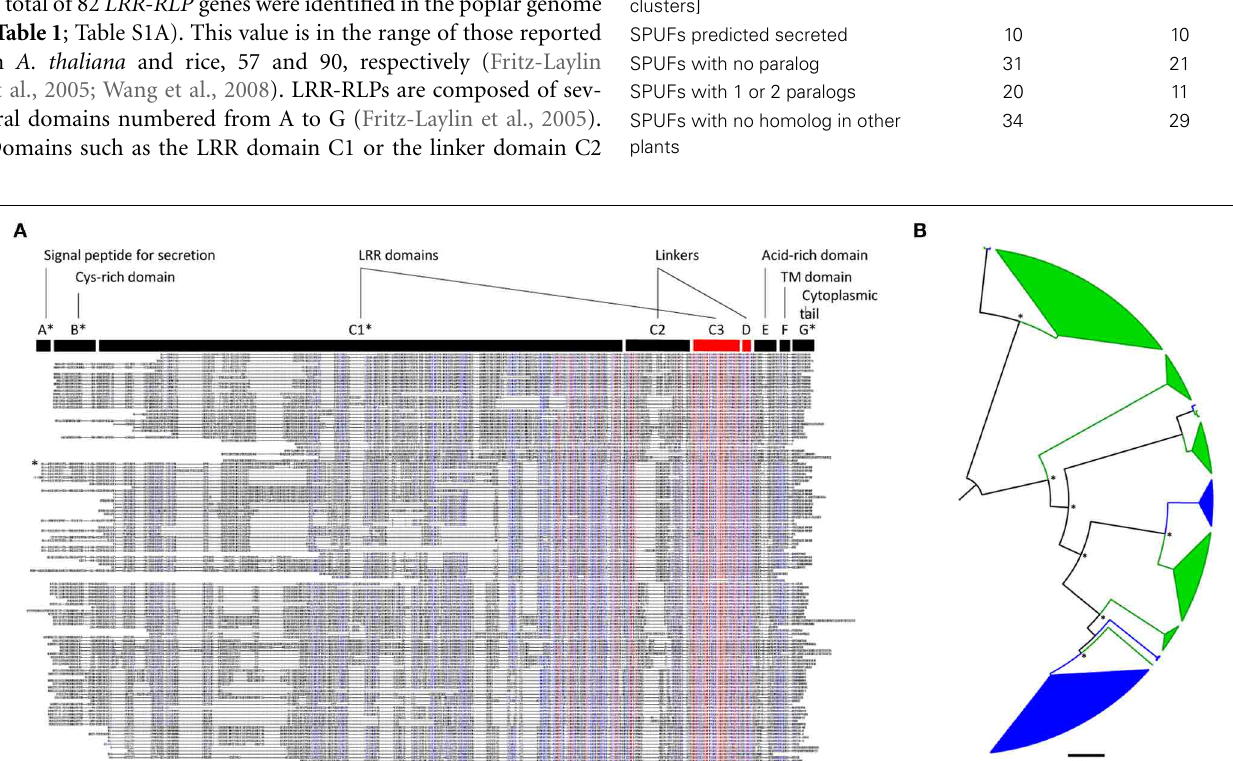
LRR-RLP9 (see text). The C3 and D domains, conserved in all sequences, are indicated in red and have been used for performing the phylogenetic analysis presented in (B) . LRR, Leucine-Rich Repeat; Cys, Cysteine; TM, Trans-Membrane. (B) Phylogenetic tree of poplar and A. thaliana LRR-RLP families. The analysis was done with the C3-D domains presented in (A) . Poplar sequences are highlighted in green, whereas arabidopsis sequences are in blue. Main nodes with Approximate Likelihood-Ratio Test (aLRT) values superior to 0.7 are marked with an